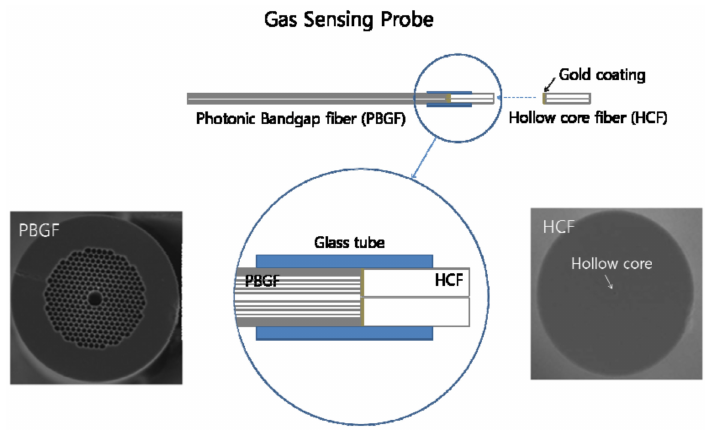
Figure 8. Schematic structure of the gas-sensing probe with an replaceable insert